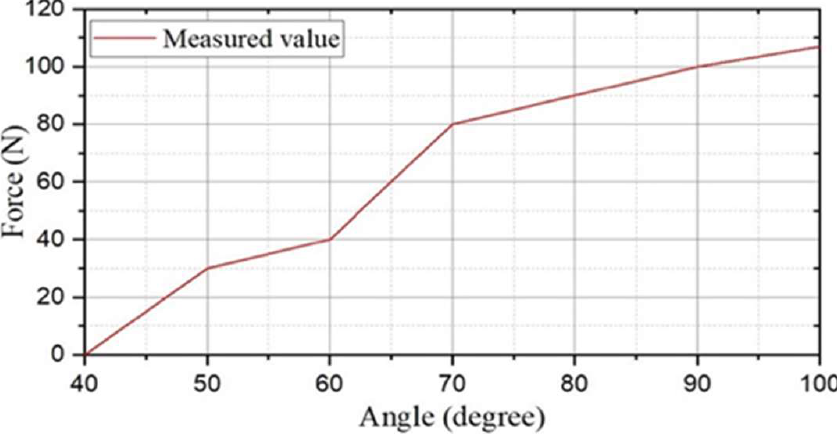
Figure 10. Relationship of the angle and thrust.